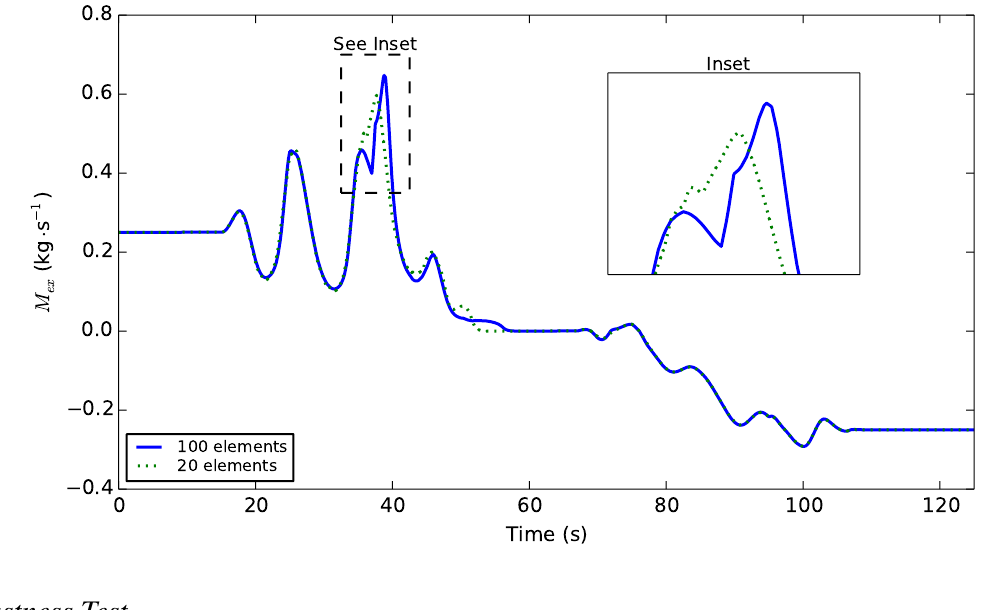
Figure 6. Prediction of the outlet flow rate under flow reversal, upwind discretization with 100 and 20